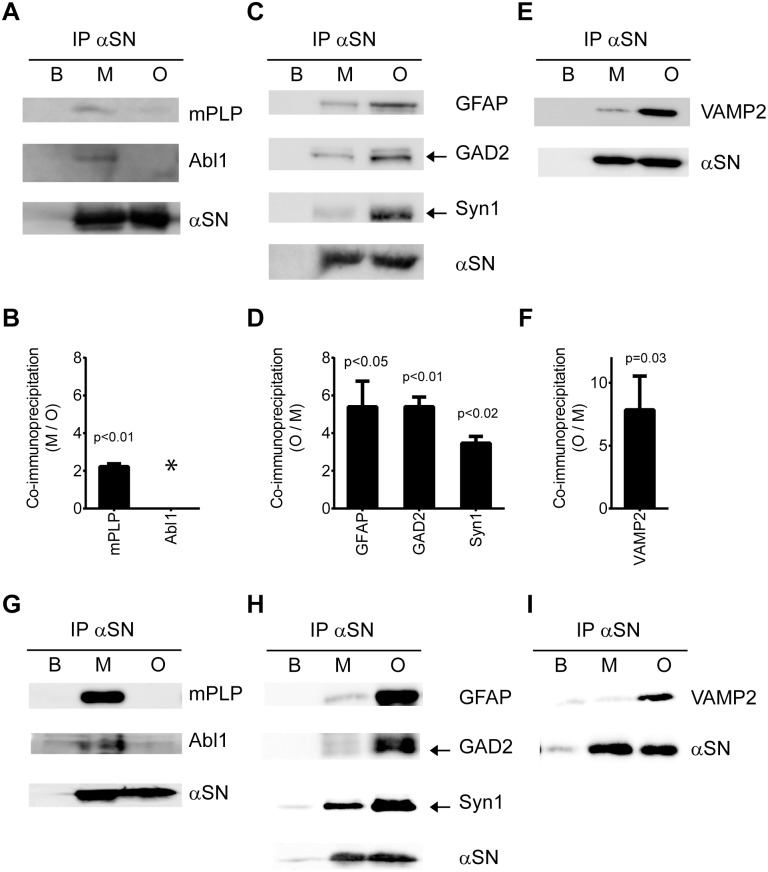
Validation of monomer and oligomer preference of αSN interacting proteins.Proteins pulled down by monomer αSN (M), oligomer αSN (O), and buffer control (B) from porcine (A-F) and human (G-I) brain extracts were analyzed by immunoblotting using antibodies against antigens selected among the monomer and oligomer binding proteins. Monomer binding antigens were myelin proteolipid protein (mPLP) and Abl interactor 1 (Abl1) and oligomer binding proteins were glial fibrillary acidic protein (GFAP), glutamate decarboxylase 2 (GAD2), and synapsin 1 (Syn1). VAMP-2 was tested because it has been reported to bind αSN, although it was not detected in our proteomic analysis. One representative of three experiments is presented for porcine αSN binding proteins (A, C, E), and the quantification of the three experiments is presented in panels B, D, F. The quantification of bands was performed after subtracting the non-specific signal in the buffer control from the specific bands in monomer and oligomer samples. Bars represent mean ratio between monomer and oligomer ± S.D. of the three replicates. The values for binding to monomer and oligomer were compared by Student’s t-test and the resulting p-values are listed above the bars. * Indicates that the band intensity from oligomer did not differ significantly from background making quantifications impracticable. In order to ensure that the interaction were not due to species differences between human and porcine proteins we conducted validations in human brain extracts. One representative of two experiments is presented for each validated protein. The validation for both porcine and human of mPLP, Abl1, Syn1 and VAMP-2 was conducted in the LP2 fraction enriched in synaptic vesicle and the validation to GFAP and GAD2 in the LS1 fraction of synaptosomal lysate.